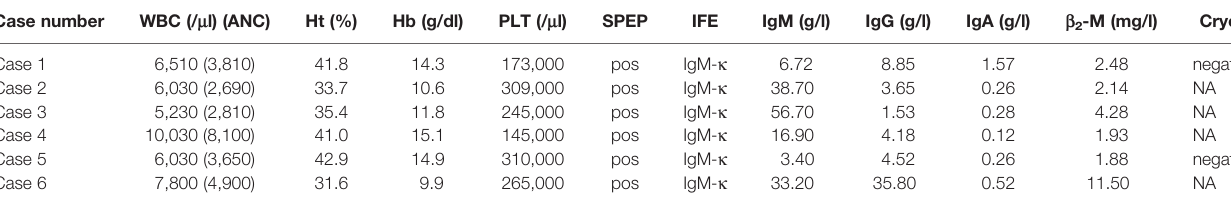
TABLE 3 | Laboratory fi